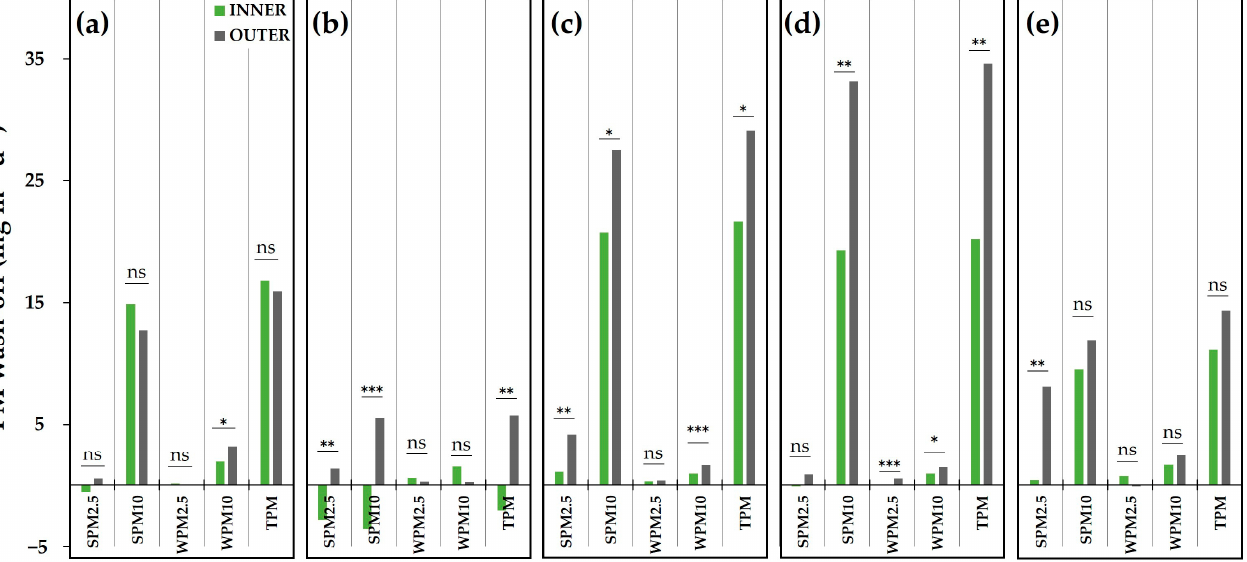
Figure 2. Net PM wash-off ability during rainfall events between inner (INNER) and outer (OUTER) crown-positioned leaves in each PM particle size fraction. ( a ) P. yedoensis , ( b ) Q. acutissima , ( c ) M. glyptostroboides , ( d ) E. japonicus , and ( e ) P. densiflora . Data are mean, n = 5. Bars with asterisks denote statistical differences between inner (INNER) and outer (OUTER) crown-positioned leaves in each PM particle size fraction within each tree species (* p < 0.05; ** p < 0.01; *** p < 0.001; ns: not significant, p > 0.05). Abbreviations: SPM2.5, surface PM2.5 on leaves; SPM10, surface PM10 on leaves; WPM2.5,